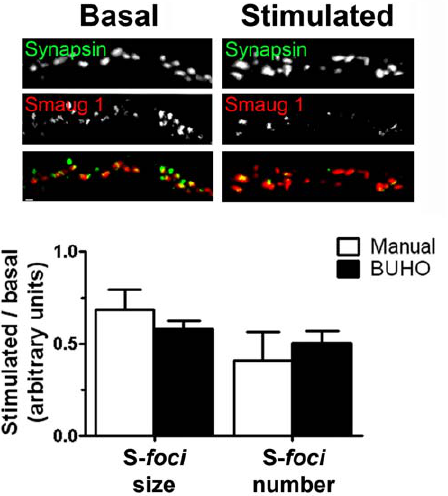
Figure 4. S- foci dissolution upon synaptic stimulation. Cultured rat neurons were stimulated with NMDA and S- foci and synapses were identified with specific antibodies as indicated in Materials and Methods. The S- foci size and the number of synapses containing S- foci in their surroundings at a distance lower than 0.5 m m were evaluated. S- foci smaller than 0.2 m m 2 were not included. Six micrographs (63 6 , 1024 6 1024 pixels), containing 4180 synapses were analyzed using BUHO, and a subset of 200 representative synapses were analyzed manually. Values relative to basal conditions are plotted. Error bars indicate standard deviation. Size bar, 2 m